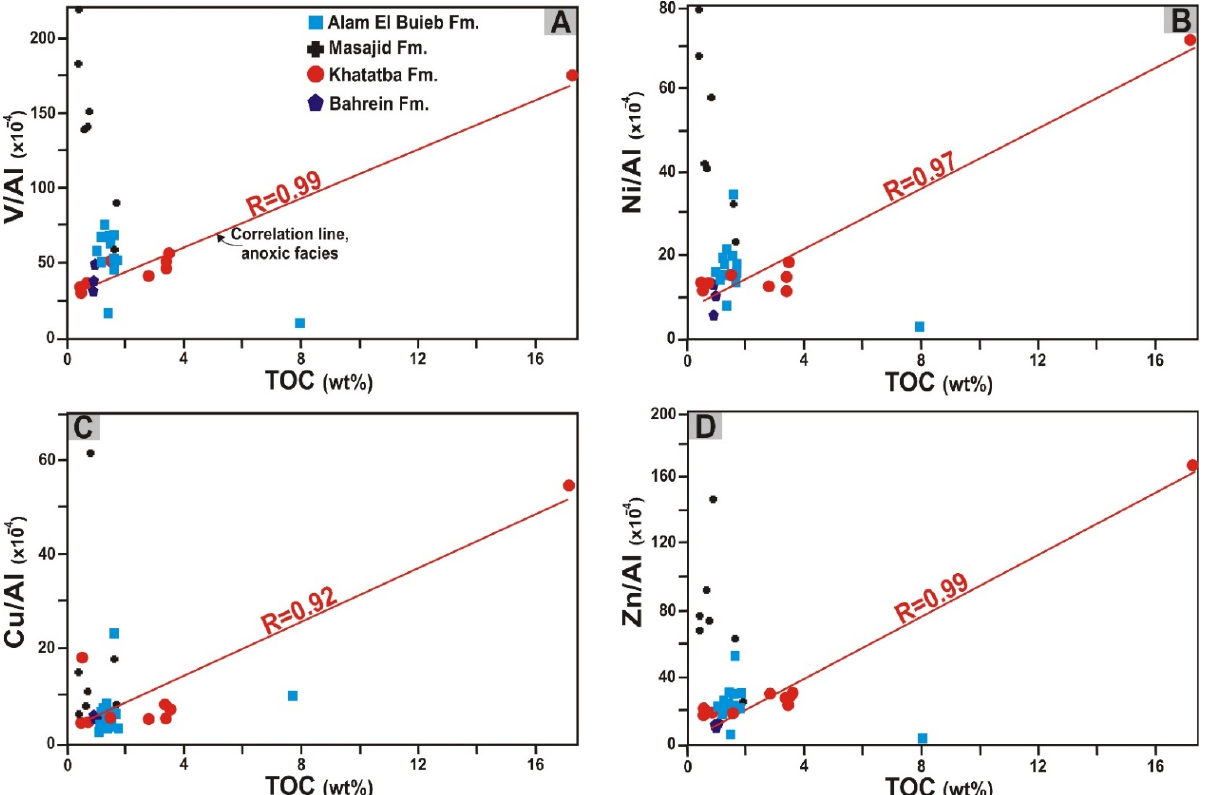
Figure 4. ( A – D ) Relationships between Al-normalized redox-sensitive elements of V, Ni, Cu, and Zn, respectively, versus TOC concentration for the Jurassic–Lower Cretaceous Bahrein, Khatatba, Masajid, and Alam El Bueib Formations in the Almaz-1 well, Shushan Basin (modified after Algeo and Maynard [28]). Lines of correlation in ( A – D ) are observed for Khatatba Formation samples.